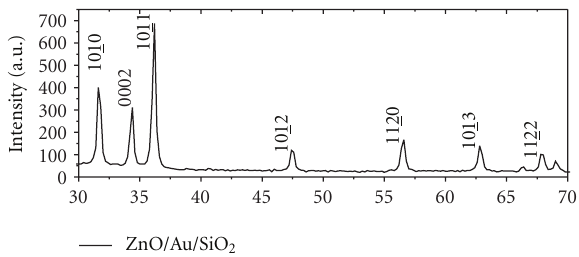
Figure 2: XRD di ff raction pattern of ZnO grown by